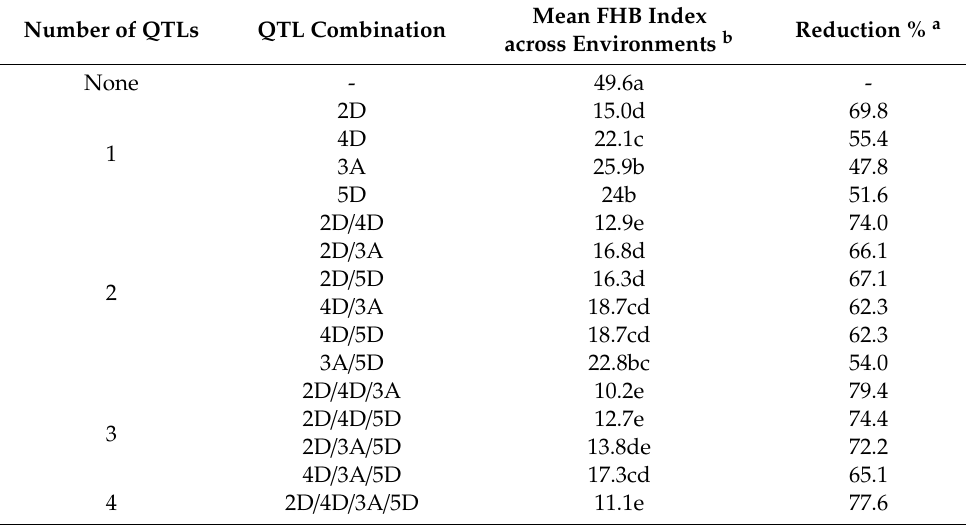
Table 6. E ff ect of individual or combined QTL on FHB response.